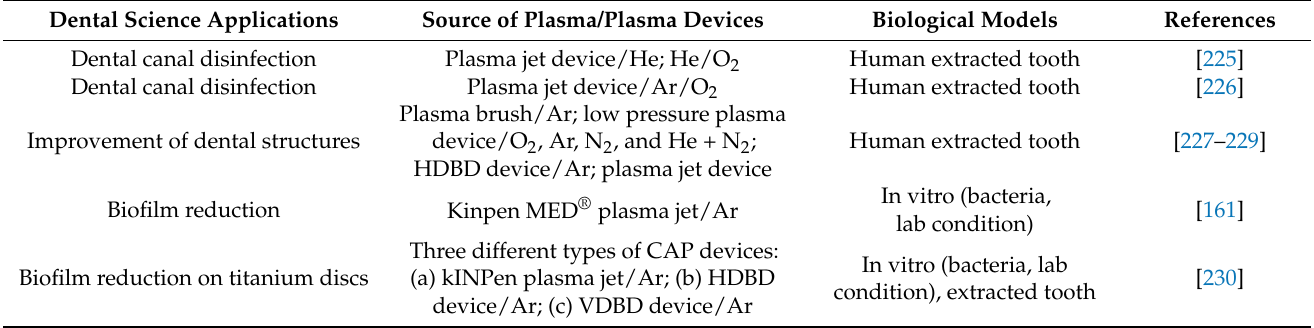
Table 4. Plasma applications in dentistry